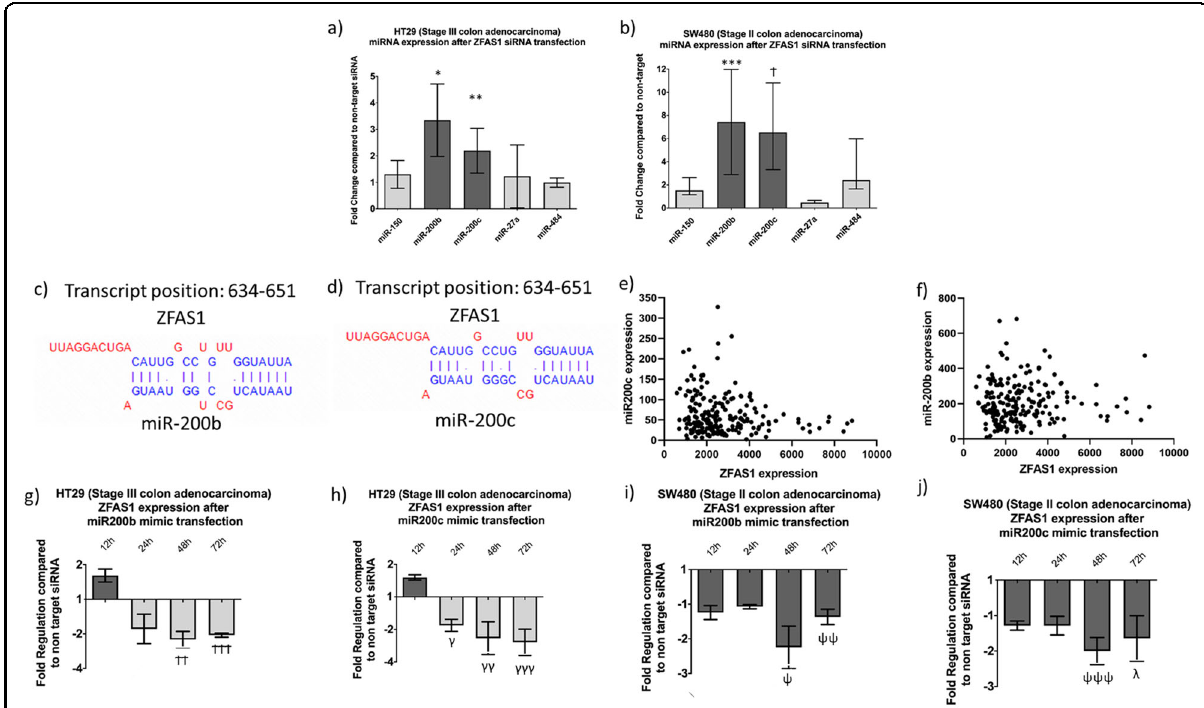
Fig. 3 Examination of the interactions between ZFAS1 and target miRNAs. a ZFAS1 knockdown leads to increased miR-200b (FC = 3.34, * p = 0.01) and miR-200c (FC = 2.28, ** p = 0.012) expression using RTqPCR in the HT29 cell line ( n = 6 replicates). b ZFAS1 knockdown leads to increased miR-200b (FC = 6.69, *** p = 0.005) and miR-200c (FC = 6.53, Ϯ p = 0.022) expression using RTqPCR in the SW480 cell line ( n = 6 replicates) . c The experimentally validated site of interaction between ZFAS1 and miR-200b is shown. d The experimentally validated site of interaction between ZFAS1 and miR-200c is shown. e Using the Cancer Genome Atlas data set, miR200c was inversely correlated with ZFAS1 expression ( n = 199, RNA-seq and miRNA-seq expression data) (Spearman r = 0.120, p = 0.09. f Using the Cancer Genome Atlas, miR200b was not inversely correlated with ZFAS1 expression ( n = 199, RNA-seq and miRNA-seq expression data) (Spearman r = 0.03, p = 0.65). g Following transfection with miR-200b mimics, there is sign fi cantly decreased ZFAS1 expression using RTqPCR at 48 (FR = − 2.33, ϮϮ p = 0.001) and 72 (FR = − 2.074, ϮϮϮ p = 0.008) hours after transfection ( n = 6 replicates). h Following transfection with miR-200c mimics, there is sign fi cantly decreased ZFAS1 expression using RTqPCR at 24 (FR = − 1.74, γ p = 0.041), 48 (FR = − 2.53, γγ p = 0.015) and 72 (FR = − 2.78, γγγ p = 0.026) hours after transfection in the HT29 cell line ( n = 6 replicates). i Following transfection with miR-200b mimics, there is sign fi cantly decreased ZFAS1 expression using RTqPCR at 48 (FR = − 2.33, ѱ p = 0.033) and 72 (FR = − 1.46, ѱѱ p = 0.02) hours after transfectionin the SW480 cell line ( n = 6 replicates) . j Following transfection with miR-200c mimics, there is signi fi canlty decreased ZFAS1 using RTqPCR at 48 (FR = − 1.99, ѱѱѱ p = 0.03) and 72 (FR = − 1.64, λ p = 0.02) in the SW480 cell line ( n = 6